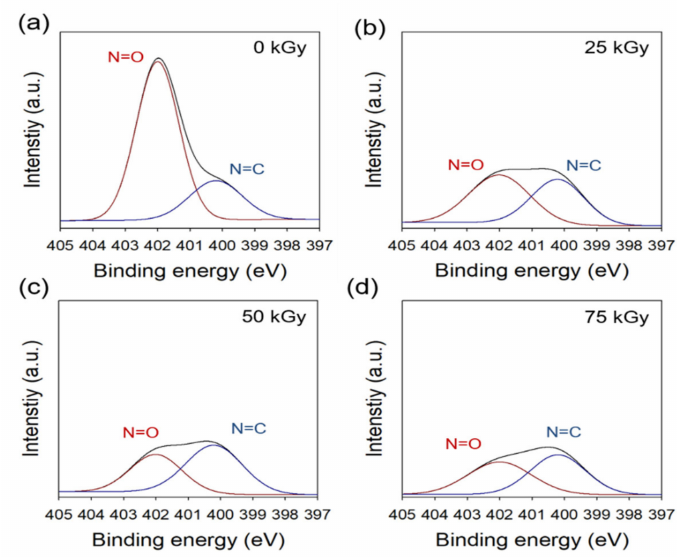
Figure 3. XPS spectra (N1s) of radiated metronidazole: ( a ) 0 kGy, ( b ) 25 kGy, ( c ) 50 kGy, and ( d ) 75